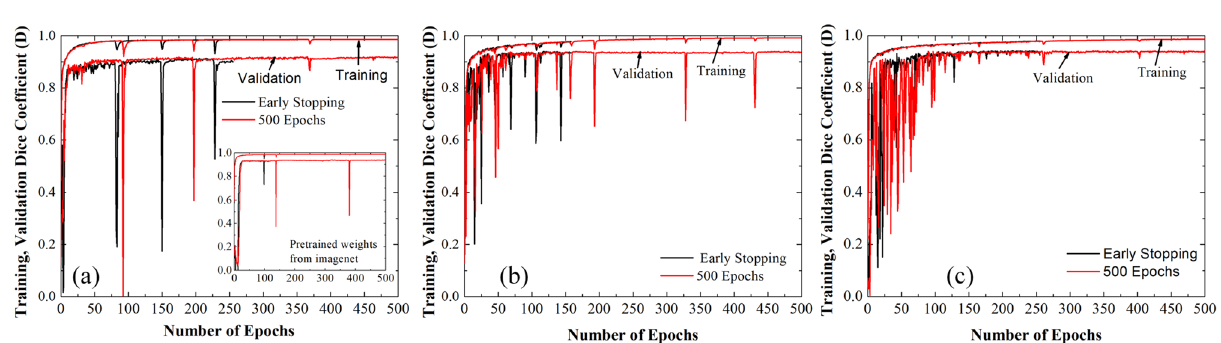
Figure 8. Variations in training and validation dice coefficient ( a ) for DeepLabv3 + , ( b ) Unet, and ( c ) LWBNA_ Unet trained for the fixed 500 epochs and stopped early by using callbacks function to avoid overfitting of the model. Each model was trained for 10 times. Here, we show the training/validation curves for the model, which produced lowest variations (out of 10 times training) in D for each case. Inset to ( a ) shows the variation in D, when the Resnet-50 encoder of DeepLabV3 + used pretrained weights of Imagenet